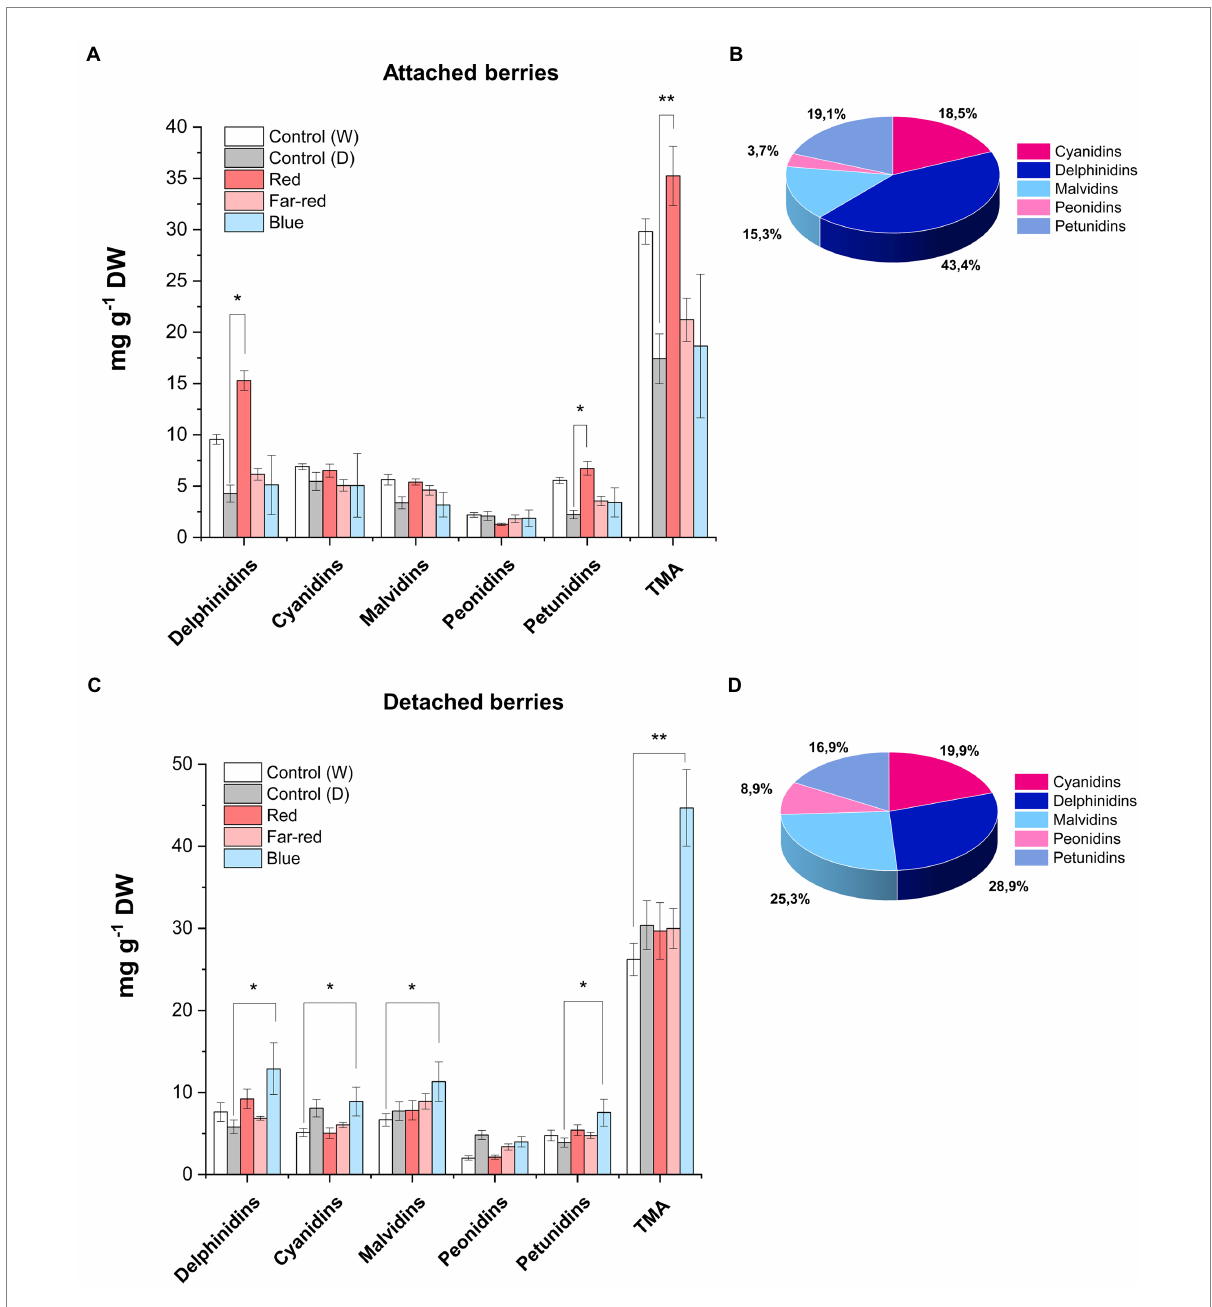
FIGURE 3 Concentrations of anthocyanins quantified by LC–MS from fully ripe bilberries under different spectral light treatments. Anthocyanin concentration in attached berries under different light conditions (A) and the anthocyanin profile in attached berries under red light (B) . Anthocyanin concentration in detached berries (C) and the anthocyanin profile in detached berries under blue light (D) . The concentrations are expressed as an average of three replicates ± SE from glucoside, galactoside and arabinoside-type derivatives from each class of anthocyanin compound. Asterisks indicate significance between the light treatments when measured using ANOVA with pairwise comparisons (* p ≤ 0.05, ** p ≤ 0.01). DW, dry